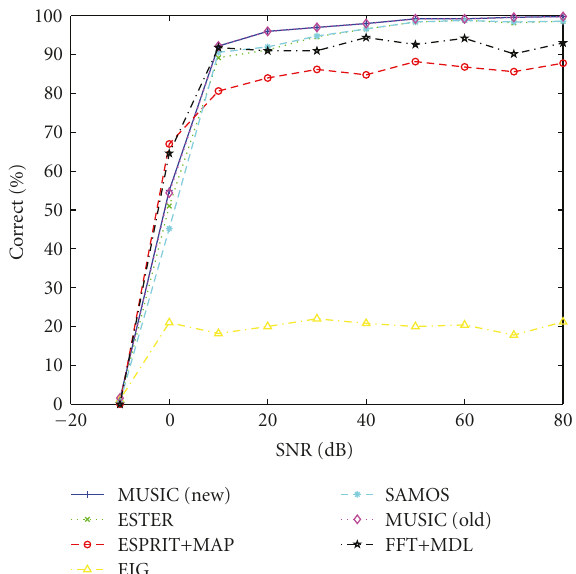
Figure 7: Percentage of correctly estimated model orders as a function of the SNR for colored Gaussian noise for N =